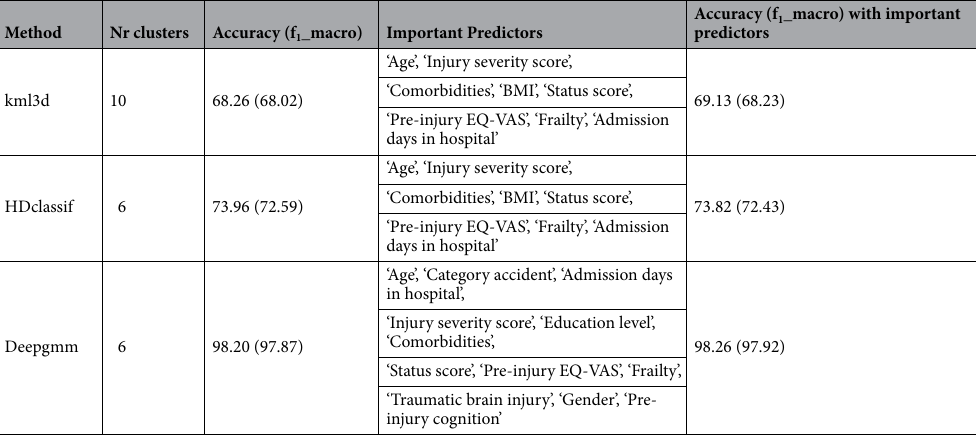
Table 4. Significant predictors and accuracy for the case of General Health and different clustering techniques before and after Boruta.